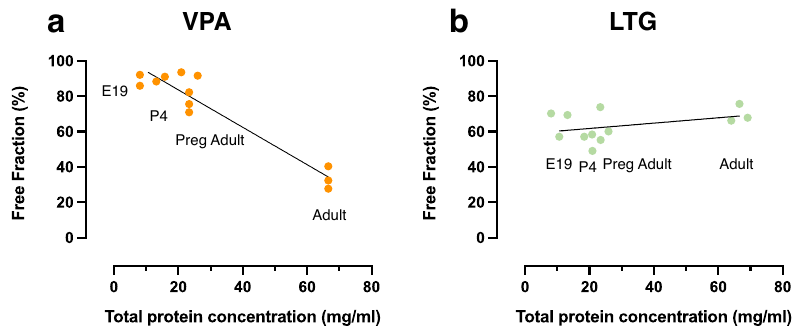
Figure 4. Relationship between free fraction of valproate and lamotrigine and total protein concentration in plasma. Protein-free fraction/whole plasma concentration ratios (%) in plasma of E19, P4, non-pregnant and pregnant female adult rats spiked with valproate ( a ) or lamotrigine ( b ) with respective [ 3 H]-labelled drugs plotted against total plasma protein concentration in each group. R 2 = 0.918 (VPA) & 0.353 (LTG). n =